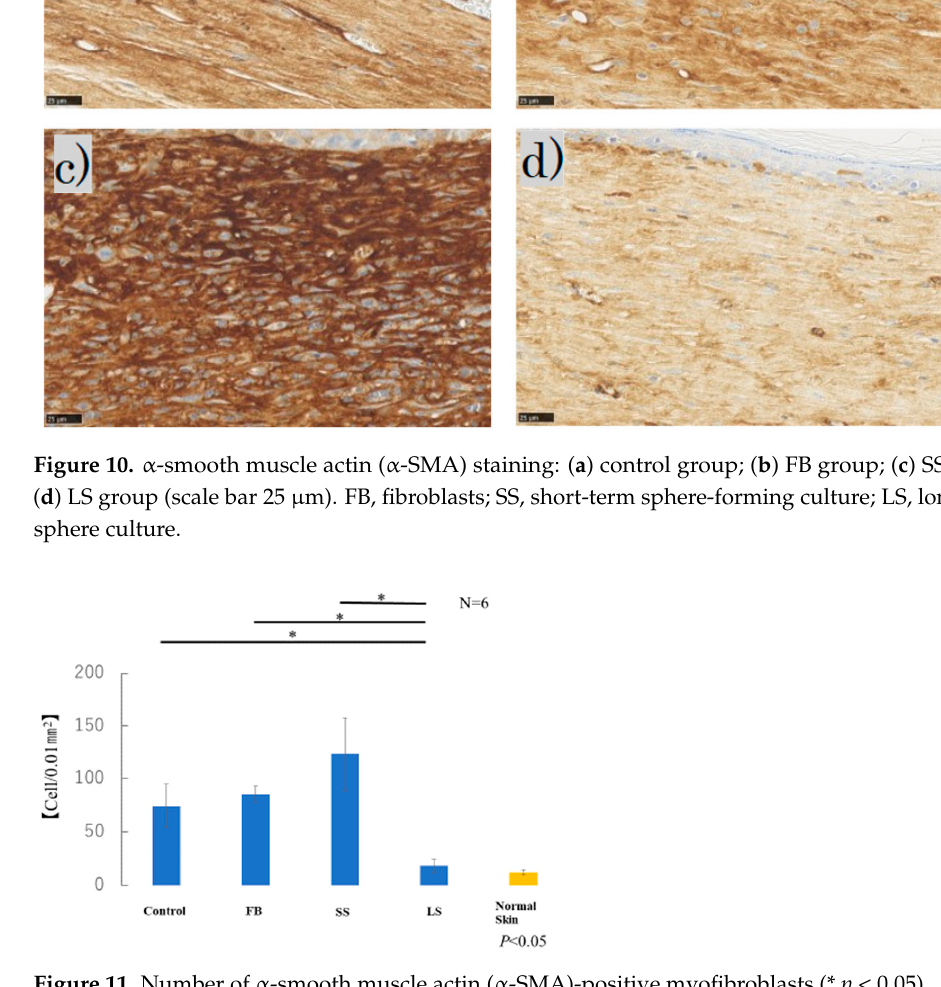
Figure 10. α -smooth muscle actin ( α -SMA) staining: ( a ) control group; ( b ) FB group; ( c ) SS group; ( d ) LS group (scale bar 25 µm). FB, fibroblasts; SS, short-term sphere-forming culture; LS, long-term sphere culture.